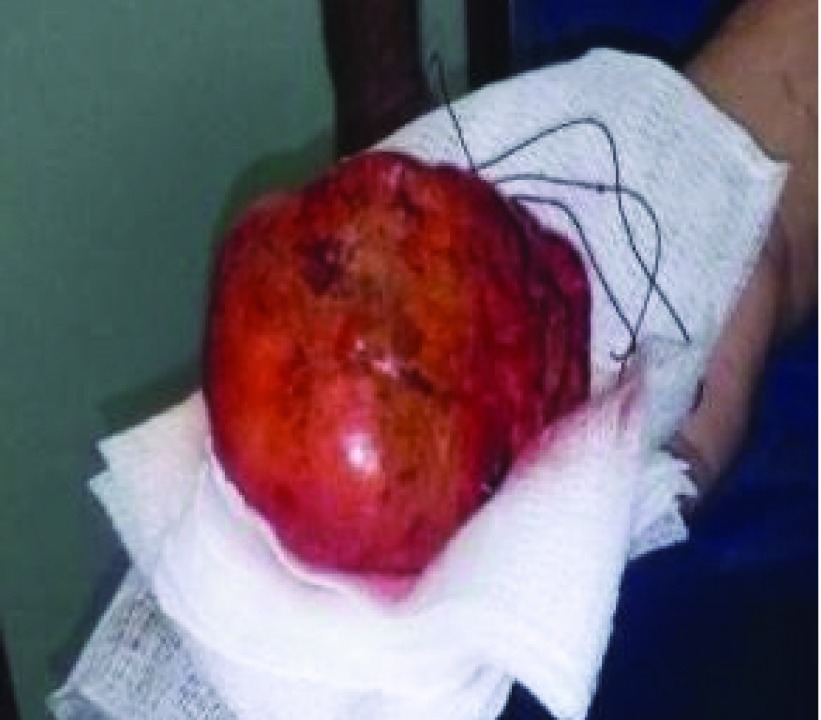
Myelolipoma evaluation.Surgical specimen, macroscopic. Amado Polyclinic, Maracaibo- Edo Zulia (10/04/2013).